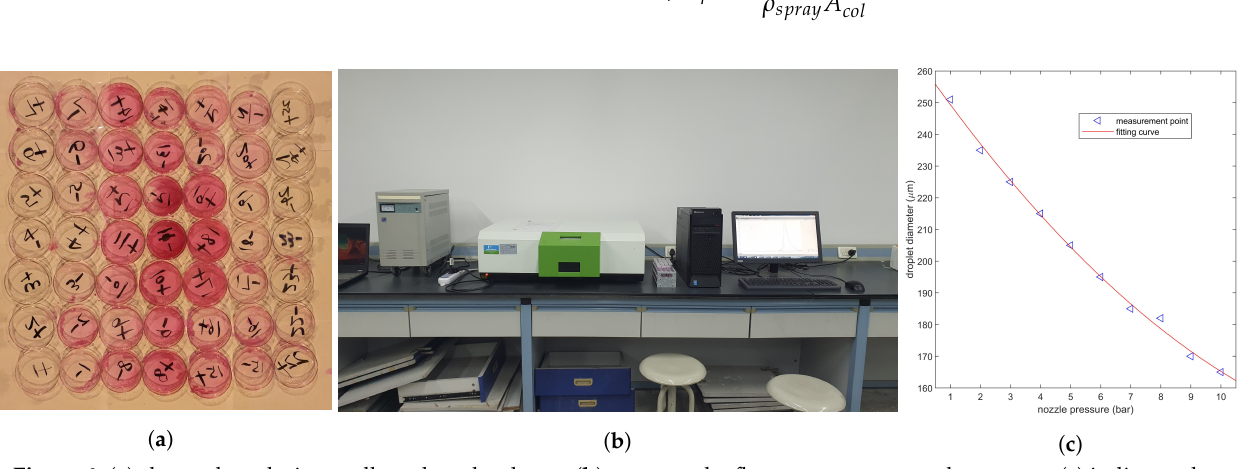
Figure 6. ( a ) shows the solutions collected on the sheets. ( b ) presents the fluorescence spectrophotometer. ( c ) indicates the characteristic curve of nozzle ( D = 0.375 × P 2 − 13.48 × P + 262.5, and root mean square error (RMSE) =